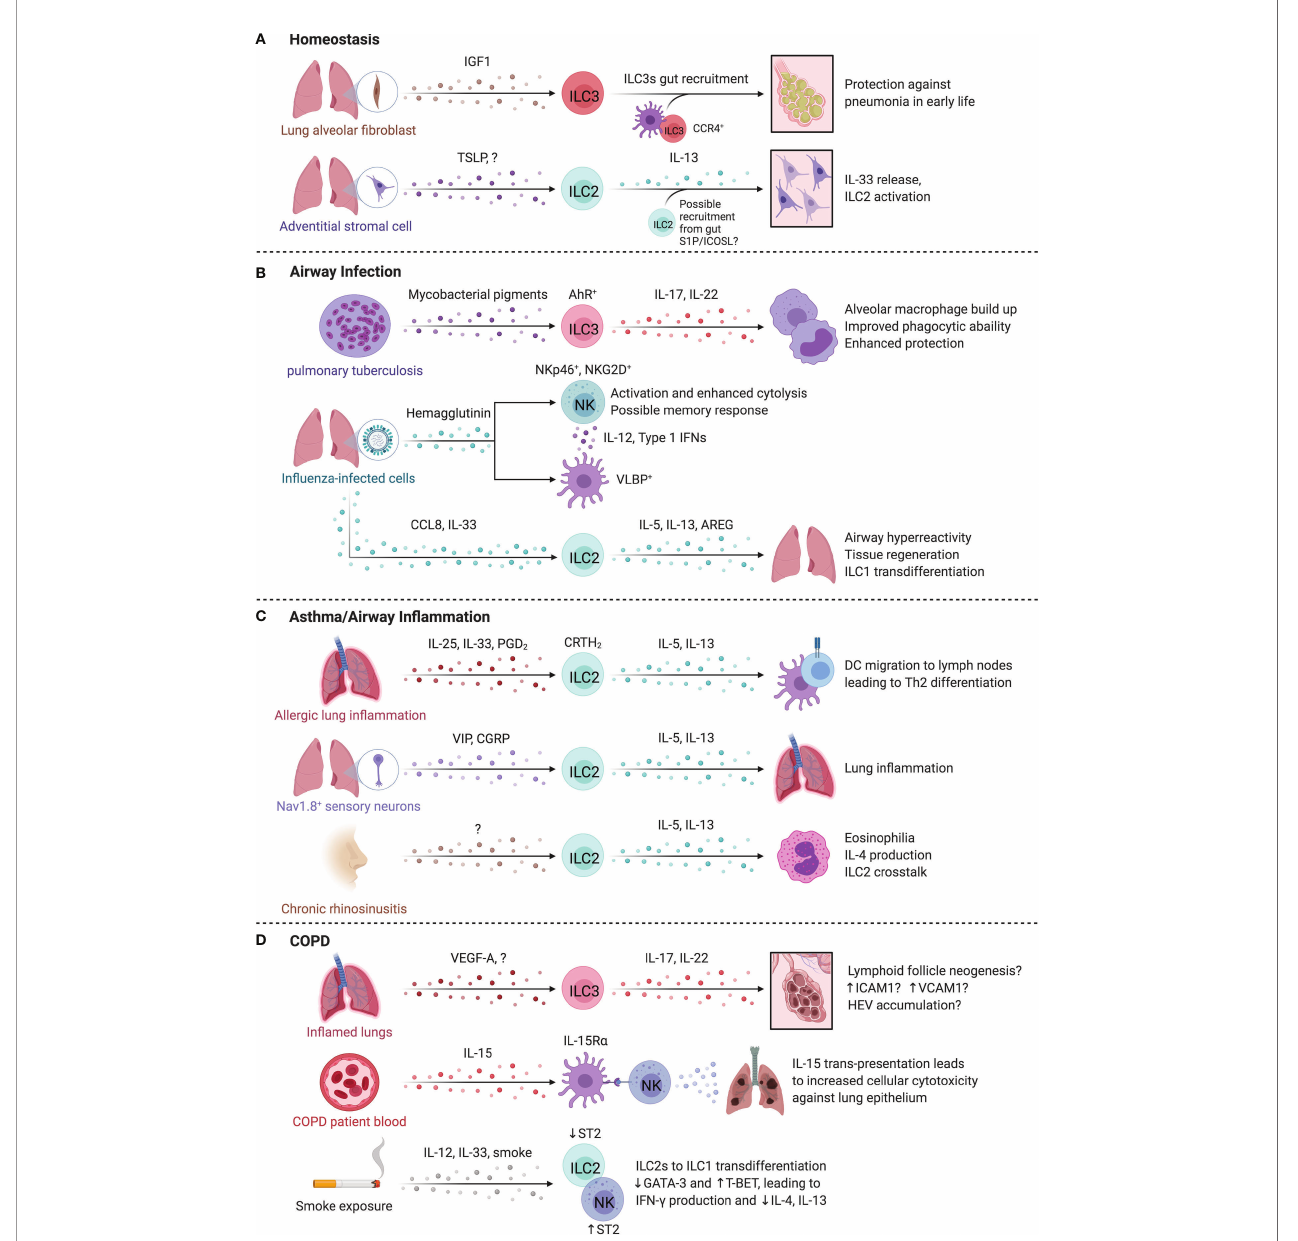
FIGURE 4 | ILCs in the lung. At homeostasis (A) , IL-22 producing ILC3s are required for protection against pneumonia and require commensal gut bacteria for their recruitment to the lungs. Once in the lung, ILC3s are sustained locally through insulin-like growth factor 1 (IGF1) from alveolar fi broblasts. In the steady state, Adventitial stromal cell-derived TSLP promotes IL-13 production by ILC2s that drives stromal cells to produce IL-33. (B) During pulmonary tuberculosis (PTB), ILC3 accumulation in the lung is regulated by pathogen-derived AhR-ligands that in turn promote phagocyte function, formation of tertiary lymphoid structures and enhanced protection. Similarly, infection by in fl uenza virus triggers NKp46-dependent activation of NK cells resulting in IL-12 and type 1 interferon secretion by DCs that promote NK cell activation. The release of CCL8 and IL-33 during respiratory viral infection facilitated ILC2 activation and AREG-dependent epithelial repair. (C) In allergic lung in fl ammation, IL-13 from ILC2s induced Th2 cell differentiation by promoting migration of activated DCs to the draining lymph nodes. In mice, administration of the CRTH2 ligand, prostaglandin D2, promotes ILC2 accumulation. Nociceptor Nav1.8+ sensory neurons activated lung ILC2s through vasoactive intestinal peptide (VIP), while pulmonary neuroendocrine cells produced calcitonin gene related-peptide (CGRP) collectively promoting allergic in fl ammation in the murine lung. Nasal polyps accumulate ILC2s in chronic rhinosinusitis, which supports eosinophils and promotes chronic airway in fl ammation. (D) IL-17A + IL-22 + ILCs and NCR - ILC3s are increased in COPD. The lungs of COPD patients and smokers contain Neuropilin 1 (NRP1)-expressing ILC3s surrounding high endothelial venules. NK cells may contribute to COPD, with higher CD57 expression, IL-15-dependent activation, and greater cytotoxicity against lung epithelial cells. Smoke exposure may lead to a sustained loss of ST2 expression on ILC2s, reducing their responsiveness to IL-33 while paradoxically promoting ST2 expression on NK cells that supports a type 1 response. Created with